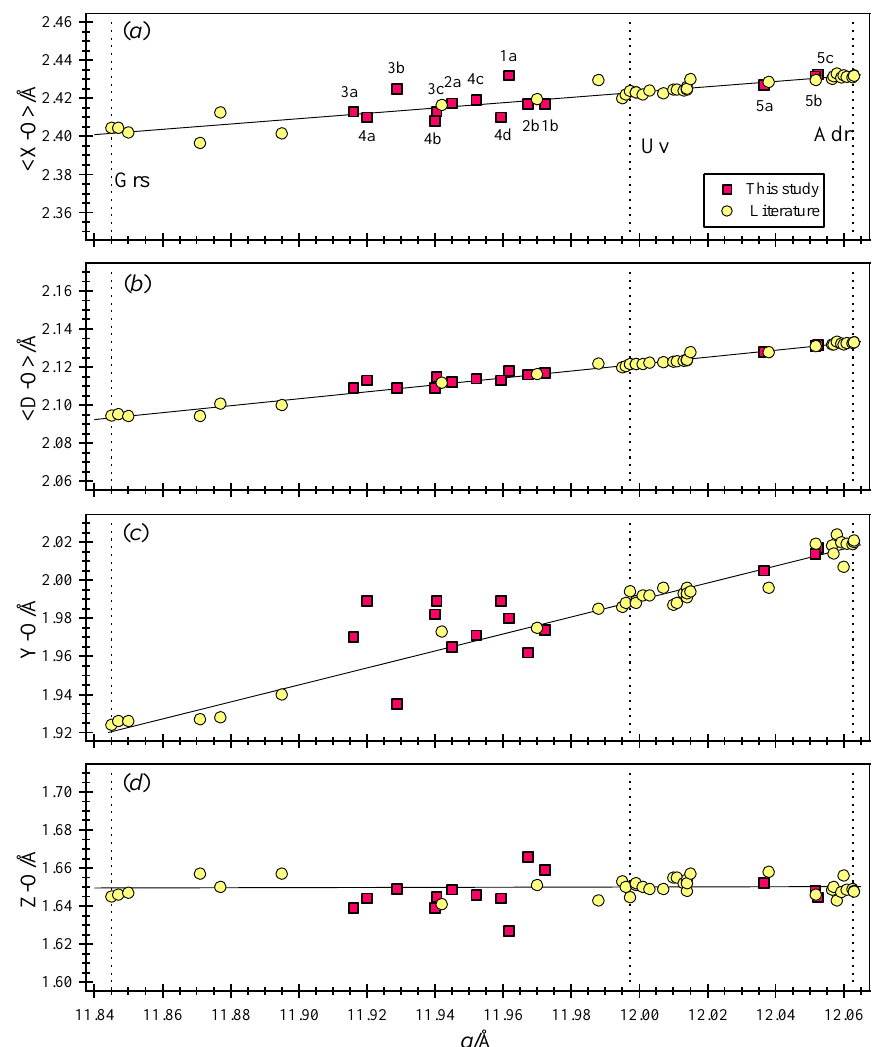
Figure 9. Structural variations for five uvarovite samples that occur between grossular (Grs; a = 11.845(1) Å [31]) and andradite (Adr; a = 12.06259(1) [7]) (dashed vertical lines). A dashed vertical line for a synthetic uvarovite (Uv) is shown ( a = 11.997 Å [18]). The ( a ) average < X–O > , ( b ) mean < D–O > , ( c ) Y–O, and ( d ) Z–O distances vary linearly with the a unit cell parameter. The intervals on the y-axis are the same in each plot (0.11 Å). The Z–O distances are nearly constant. The < X–O > and < D–O > distances change by small amounts, but the Y–O distances change the most and show the most scatter. Phase 1b and, in particular, phase 2b may contain minor amounts of (O 4 H 4 ) hydrogarnet substitution because their Z–O distance increases as their Y–O distance decreases. Error bars are smaller than the symbols.